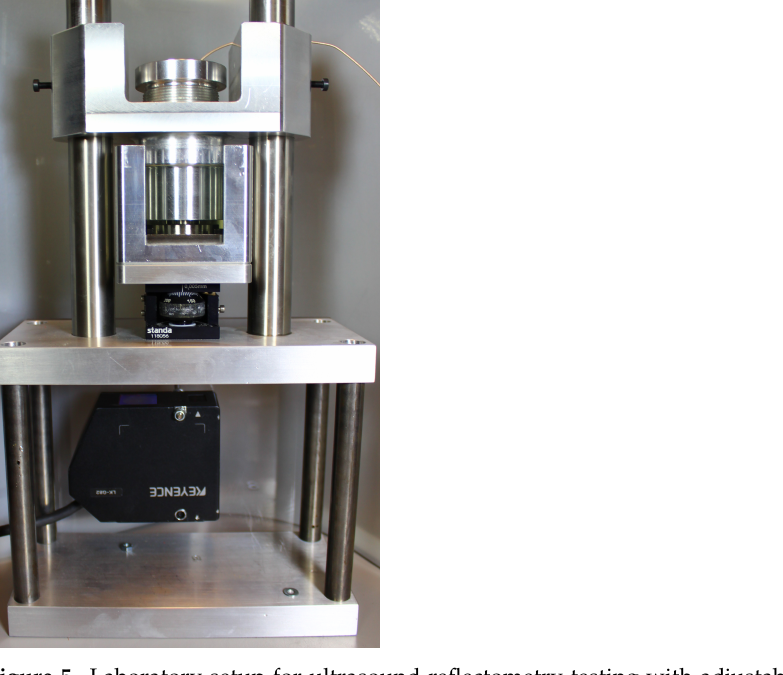
Figure 5. Laboratory setup for ultrasound reflectometry testing with adjustable lubrication film thickness and laser reference